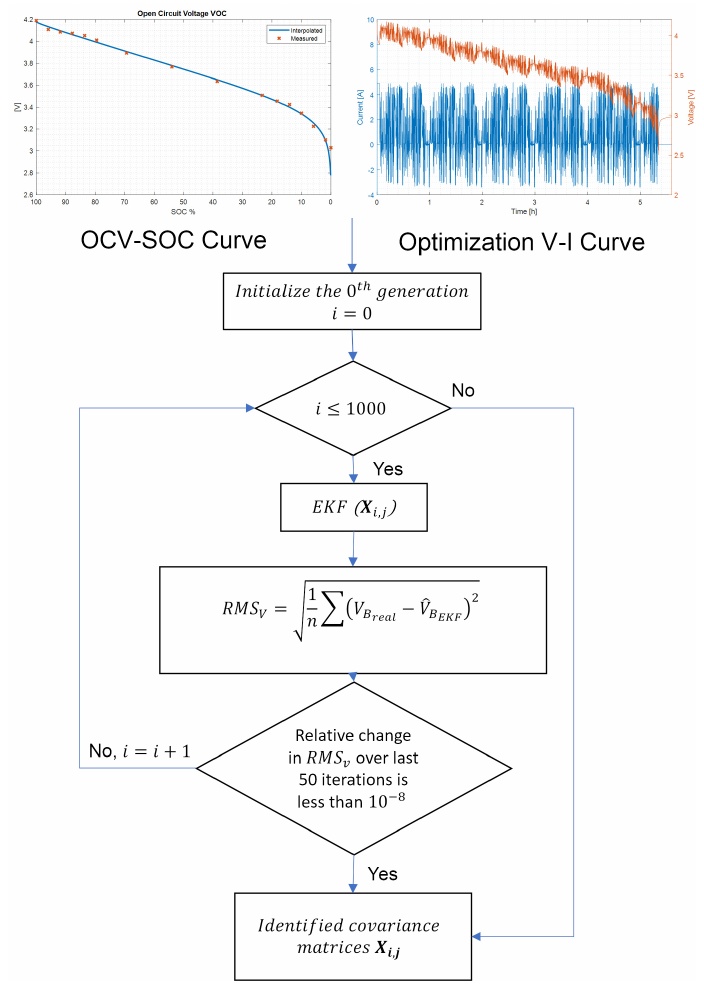
Figure 4. Flowchart of the covariance matrices optimization